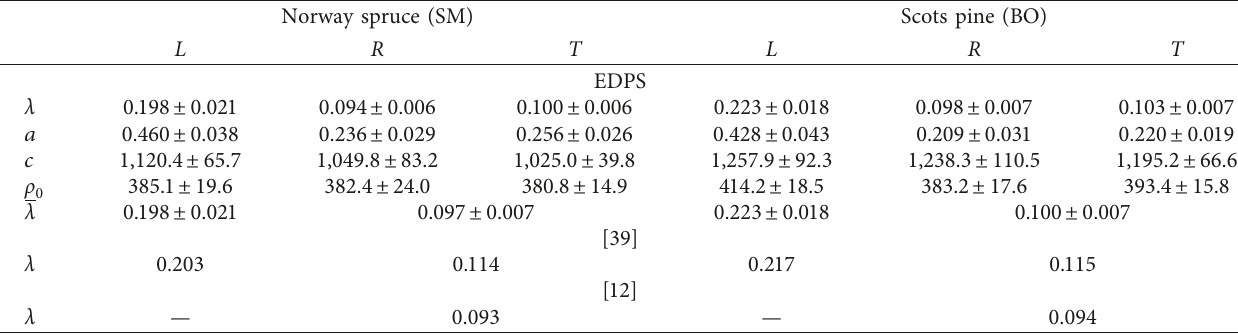
Table 2: Average thermophysical properties of Norway spruce (SM) and Scots pine (BO) at the moisture content of 0% determined by the EDPS method, models, and national building